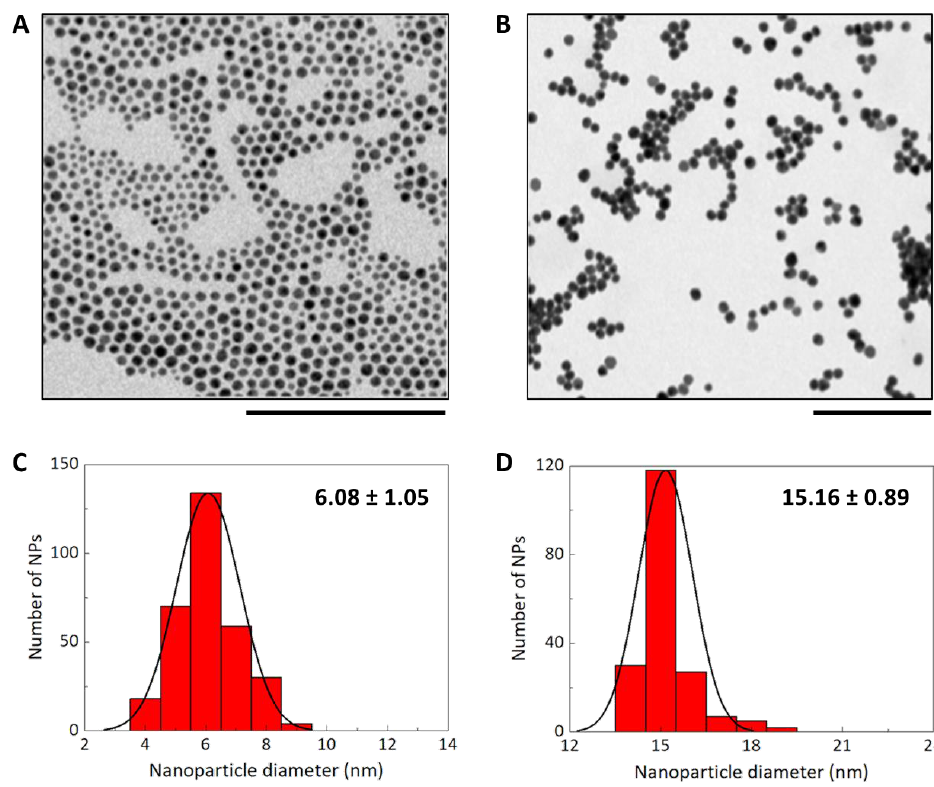
Figure 2. Transmission electron microscopy (TEM) images of GNP 6 nm ( A ) and 15 nm ( B ). Bars: 100 nm for ( A ) and 200 nm for ( B ). From the analysis of TEM images, plots of size distribution were derived for 6 nm ( C ) and 15 nm ( D ) NPs. Mean ± SD of 315 or 189 measurements for 6 or 15 nm NPs, respectively. Table 1. Characterization of GNP@PEG and GNP@PMA by dynamic light scattering (DLS). Z- potential, hydrodynamic size (distribution in number), and polydispersity index (PDI) as meas- ured by DLS. Mean ± SD of three independent experiments .